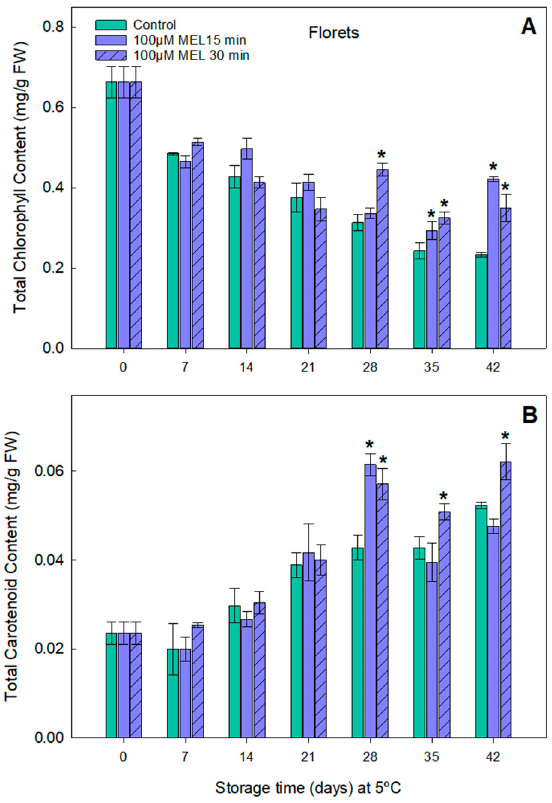
Figure 5. Effect on total content of chlorophylls ( A ) and carotenoids ( B ) in broccoli treated with 100 μ M of melatonin during 15 and 30 min and stored in the dark, at 5 °C, for 0, 7, 14, 21, 28, 35 and 42 days. Each bar represents the mean value ± standard error ( n = 3) obtained for each concentration used. Asterisks indicate significant differences with the control of that day based on a Tukey HSD test with a significance level of p < 0.05.